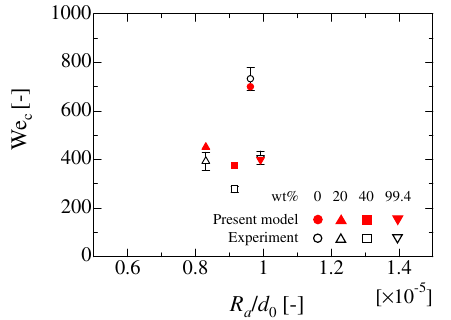
Figure 6. Comparison of the critical We calculated by Eqs. (A10) and (A18) with the experimental data for water–ethanol binary-mixture droplets on the solid substrates of SR. The horizontal axis reflects the arithmetical mean-roughness value R a normalised by the initial droplet diameter d 0 . The solid red circle represents the analytical result. The empty circle represents the experimental data. The error bar is twice of standard deviation.